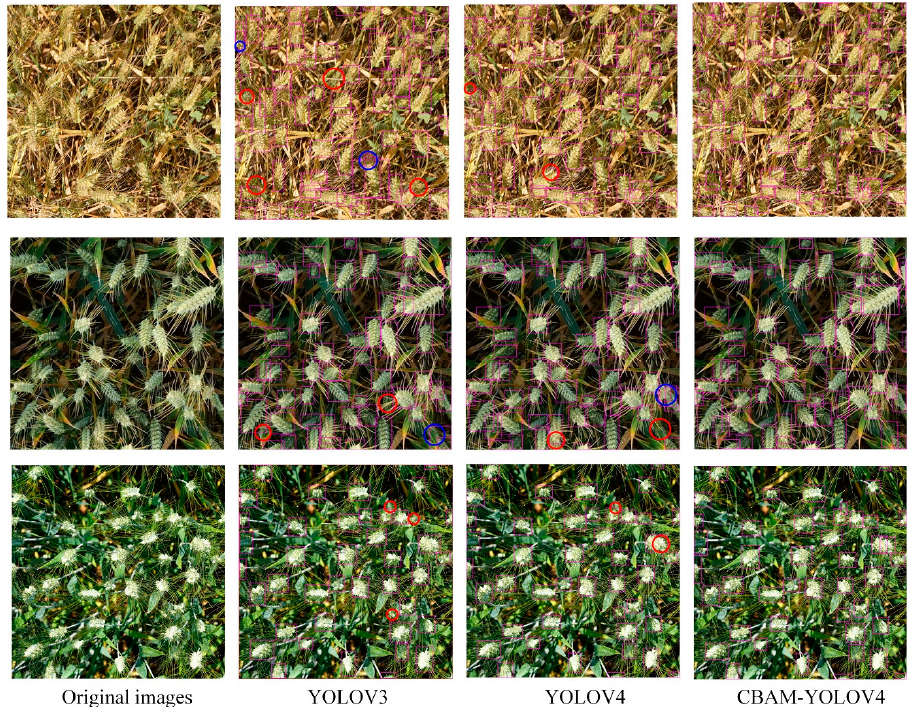
Figure 11. Examples of the results of different algorithms detecting wheat ears with the test sets.